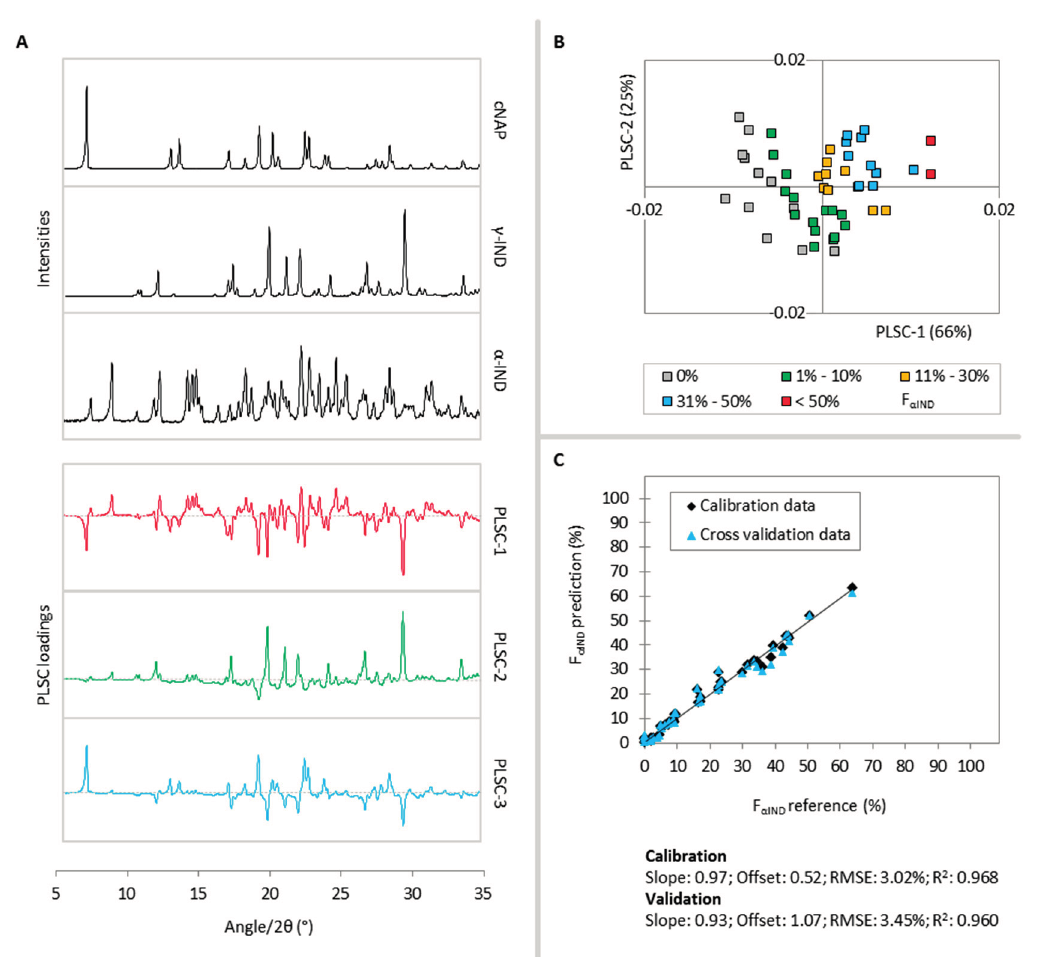
Figure 4. ( A ) Reference diffractograms of cNAP, γ -IND, α -IND (black lines) and PLSC-1 (red), PLSC-2 (green) and PLSC-3 (blue) loadings plots for the F α -IND PLS model,; ( B ) PLSC-1- vs. -PLSC-2 scores plot, the different colors classify the calibration samples according to their α -IND fractions; ( C ) Correlation of the PLS predicted α -IND fraction vs. the reference values during the calibration (black diamonds) and cross validation (blue